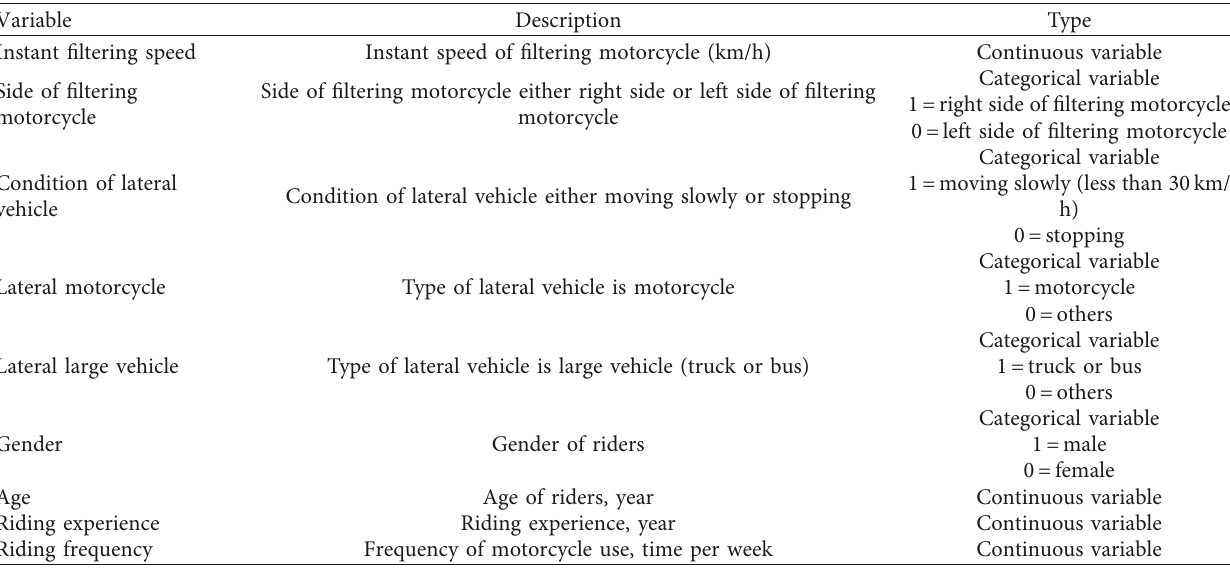
Table 3: Variable definition.